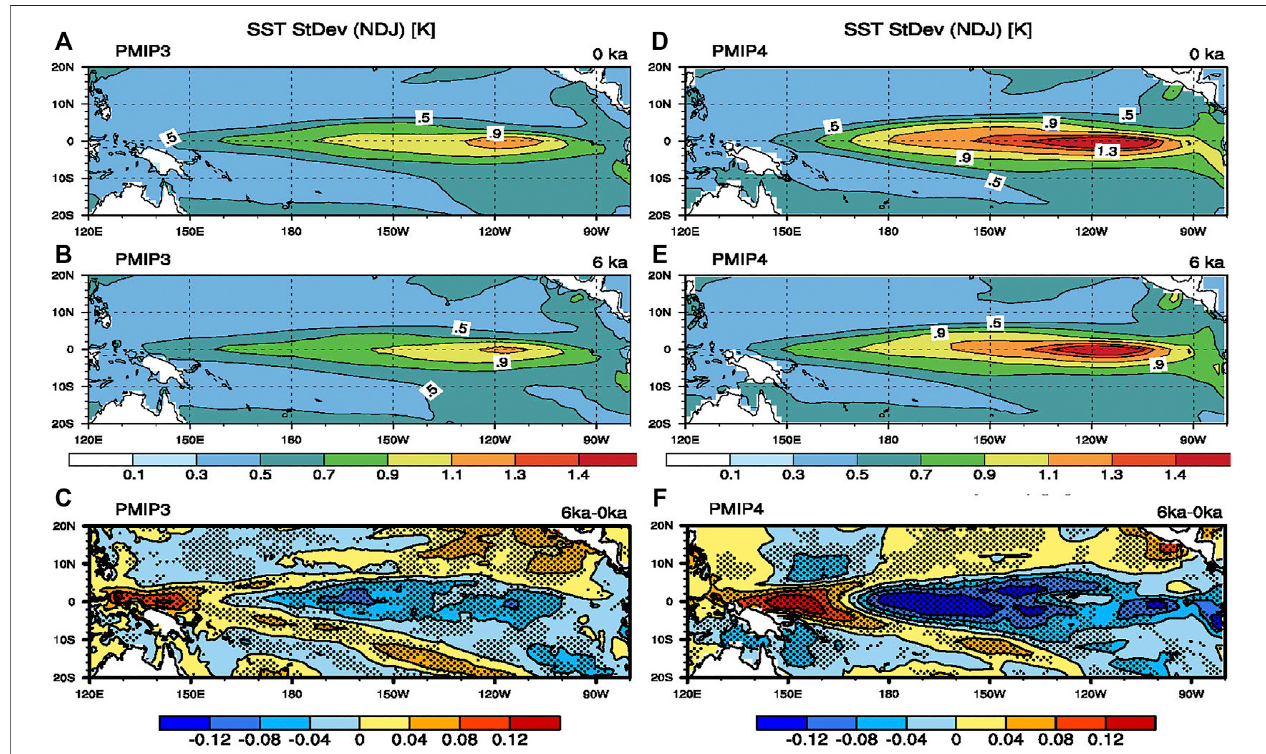
FIGURE 7 | Standard deviation of SST anomalies in boreal winter (November – January) obtained from PMIP3 (left column) and PMIP4 (right column) models. (A) and (D) are PI simulations; (B) and (E) are MH simulations; and (C) and (F) are their differences. Stippling in (C) and (F) indicates the model consistency exceeds two thirds of the total model ’ s